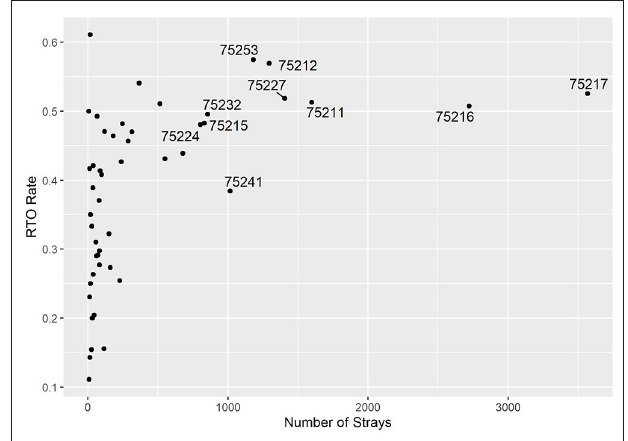
FIGURE 1 | RTO rate and the number of strays per ZIP code. Labels indicate high-intake